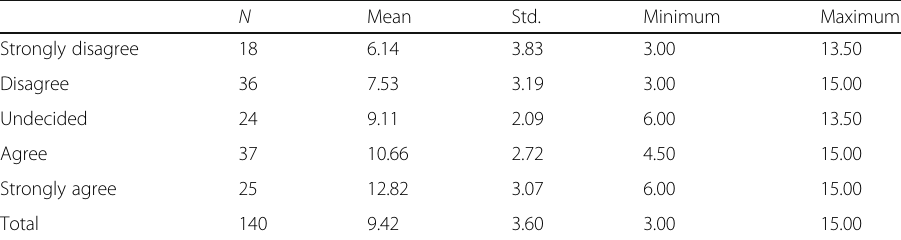
Table 6 Descriptive statistics for the inference of generalizability in the TOEFL iBT test N Mean Std. Minimum Maximum Strongly